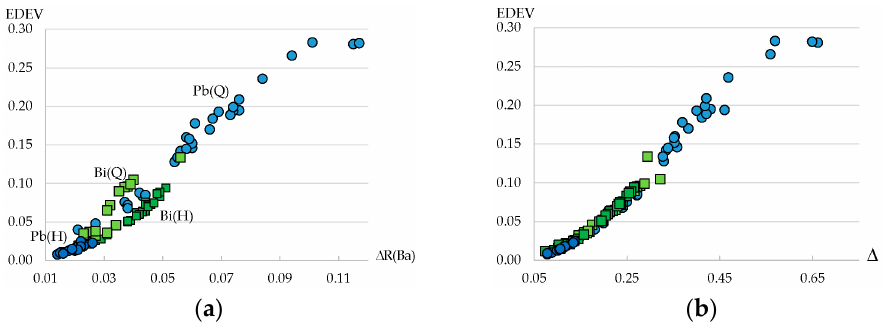
Figure 11. Correlations between EDEV X and ( a ) the Baur distortion index— ∆ R ( Ba ) , and ( b ) the displacement of the centroid— ∆ , for synthetic cannizzarite (Matzat [36]). Blue points denote Pb and the green ones, Bi. Darker hues correspond to atom positions in the H layers of the crystal structure. A synoptic view of EDEV X ranges and average values for a selection of CP in 170 sulfosalt crystal structures is shown in Figure 12. The list of crystal structures used for